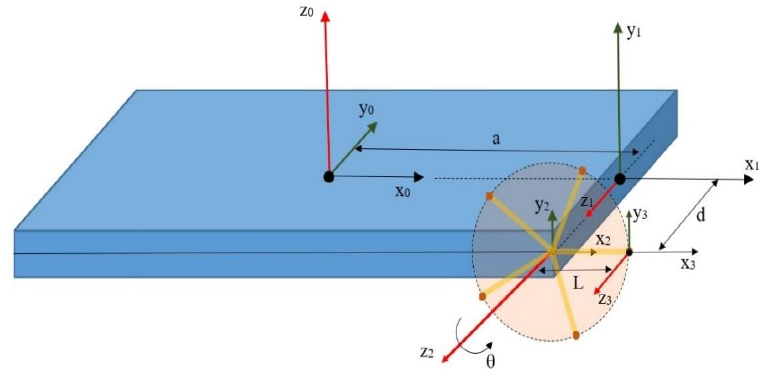
Figure 7. Robot kinematics image.